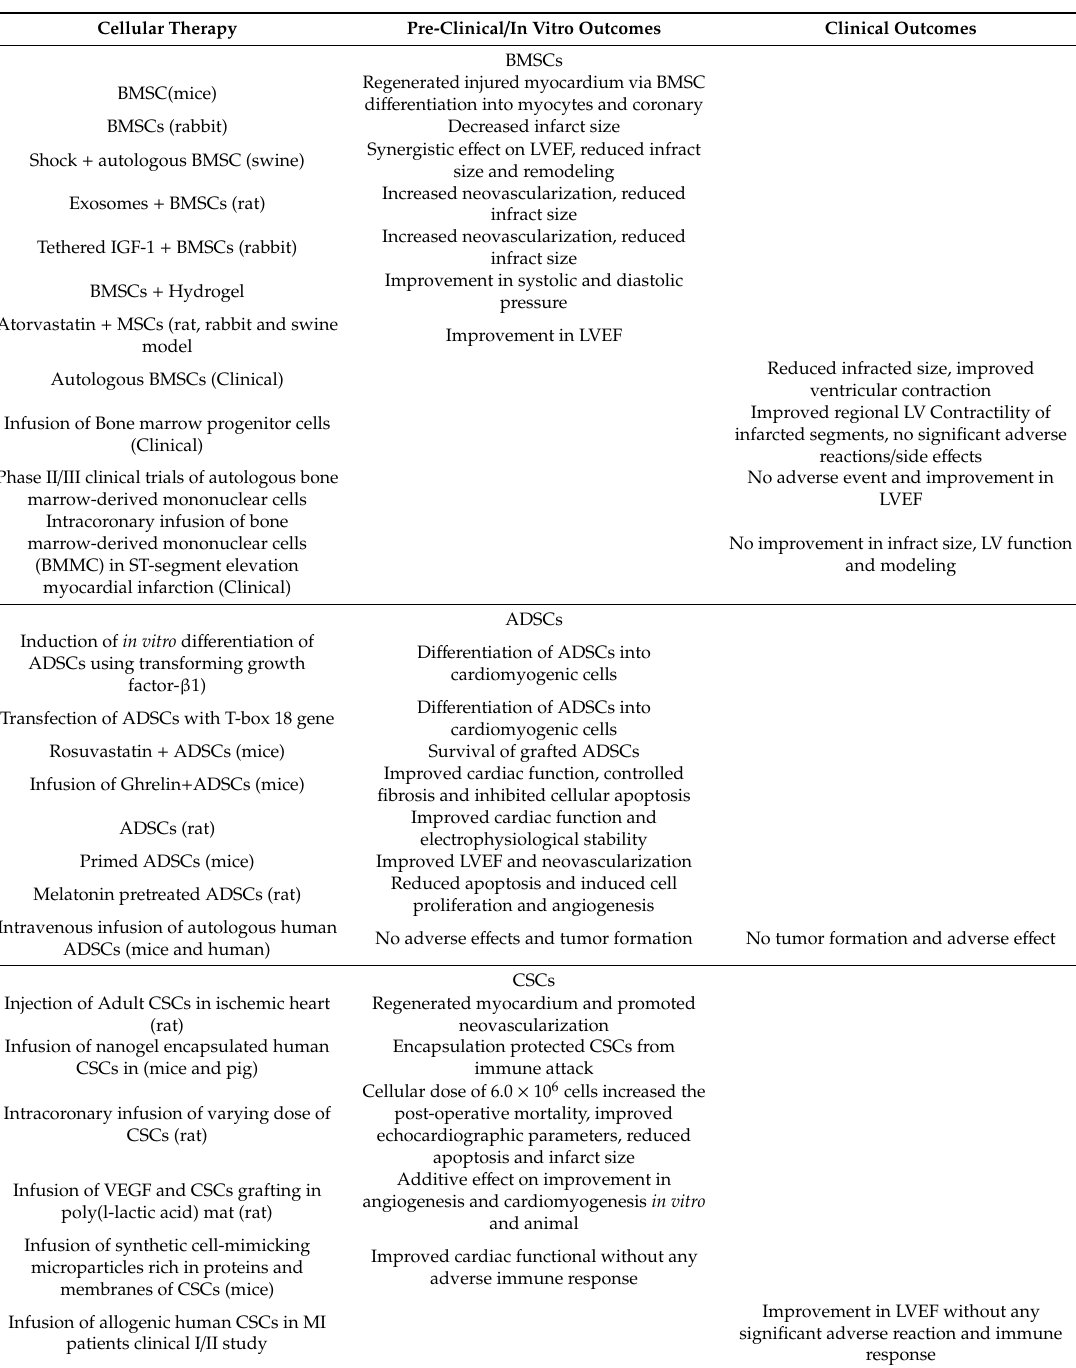
Table2. Summaryofstudiesonpre-clinicalandclinical-basedcellulartherapiesandtheirmainoutcomes during treatment of MI. The specific animal used in the pre-clinical studies has been indicated in the bracket ADSCs: Adipose derived stem cells, BMSCs: Bone marrow derived stem cells, CSCs: cardiac stem cells, ESCs: Embryonic stem cells, HGF: Hepatocyte growth factor, IGF-1: Insulin like growth factor-1, iPSC S : Induced pluripotent stem cells, LV: Left ventricular, LVEF: Left ventricular ejection fraction, MI: Myocardial infarction, PRF: Platelet-rich fibrin, PRP: Platelet-rich plasma, ROS: Reactive oxygen space, SkM: Skeletal